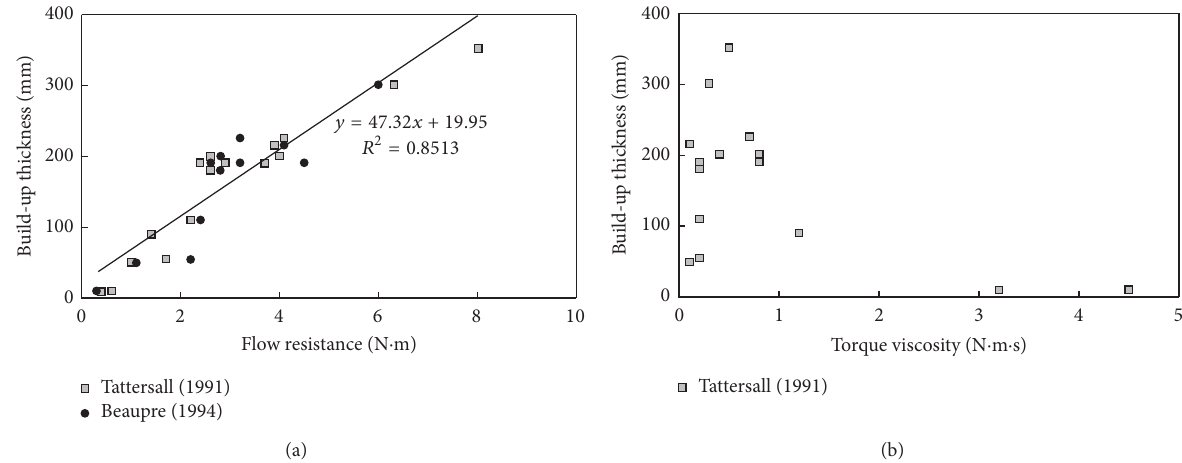
Figure 4: Relationships between rheological parameters and build-up thickness: (a) flow resistance versus build-up thickness; (b) torque viscosity versus build-up thickness [1].